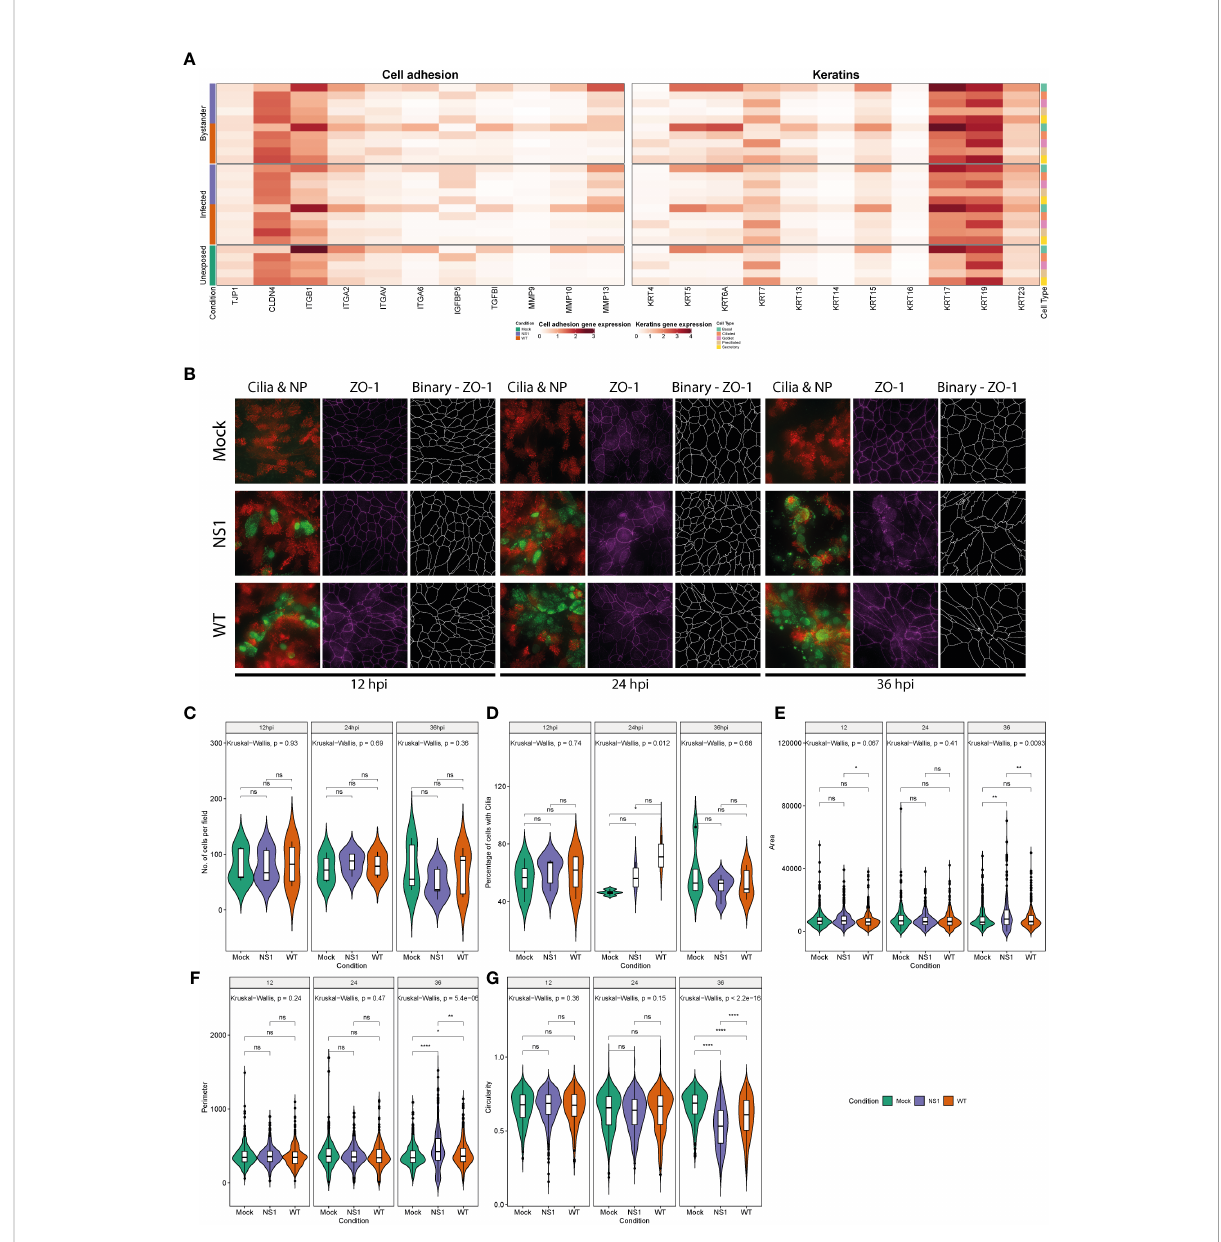
FIGURE 7 Disruption of the respiratory epithelium architecture by pandemic IAV infection. (A) Heatmap illustrating the average expression levels of a variety of genes involved in cell adhesion (left panel) or keratin genes previously linked to cell differentiation in the respiratory epithelium (right panel). Expression levels for individual genes are shown in columns and divided by the condition, cell type, and infection status (rows). (B) To monitor morphological changes hAECs were inoculated with 10,000 TCID 50 of either WT or NS1 R38A virus and fi xed at 12, 24, and 36 hpi for immuno fl uorescence analysis. Formalin- fi xed cultures were stained with different antibodies to highlight viral infected cells (nucleoprotein, green), ciliated cells (ß-Tubulin IV, red), and tight junction borders (ZO-1, purple). The tight junction images were binarized (ZO-1, white) using a custom image analysis script. Maximum intensity projection images obtained from z-stacks are shown for two different donors. Binarized tight junction images were used to calculate the following: (C) the number of cells analyzed overall, (D) the percentage of cells with cilia, (E) the surface area of individual cells, (F) the length of the tight junction border of each cell (perimeter), and (G) the shape of individual cells (circularity). Each measurement was calculated for mock (green), WT (orange), and NS1 R38A (purple) virus-infected hAEC cultures at 12, 24, and 36 hpi. Data represent the mean ± SD of individuals cells counted at each time point from 2 different donors for each condition (ns, p > 0.05, *p ≤ 0.05, **p ≤ 0.01, ****p ≤